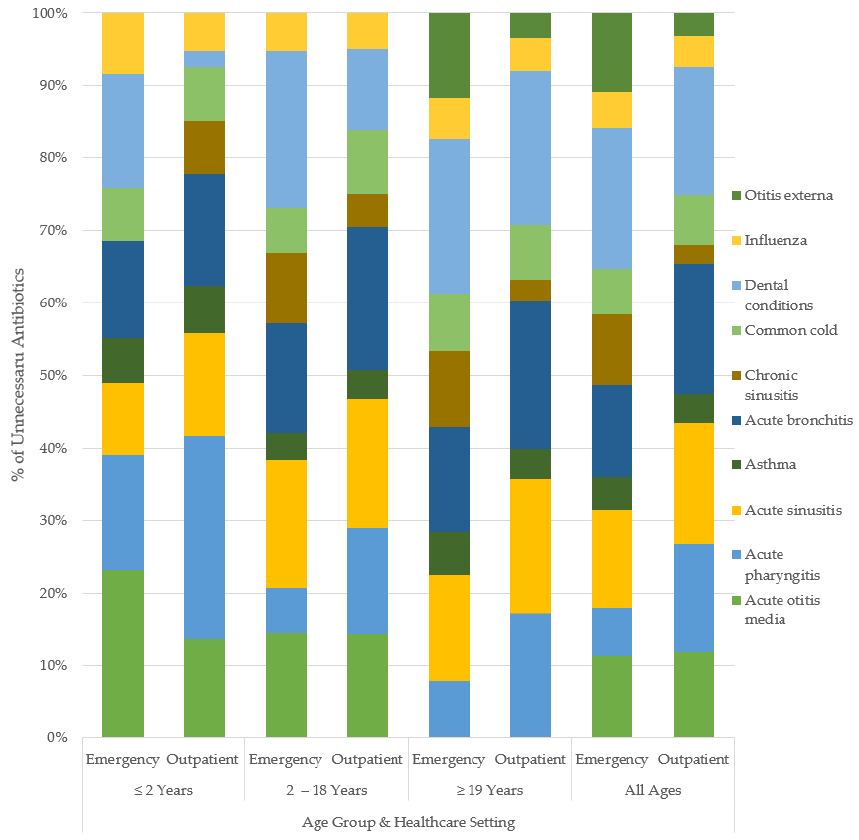
Figure 3. Percent unnecessary antibiotic use for common conditions, by age and healthcare setting.